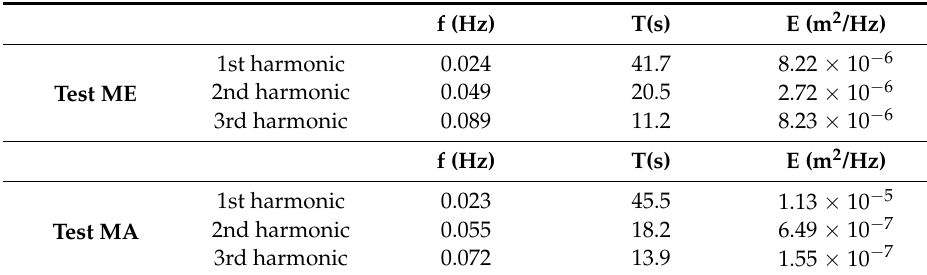
Table 5. Peak frequencies, periods and power spectral density for monochromatic tests under erosive (ME) and accretive (MA)